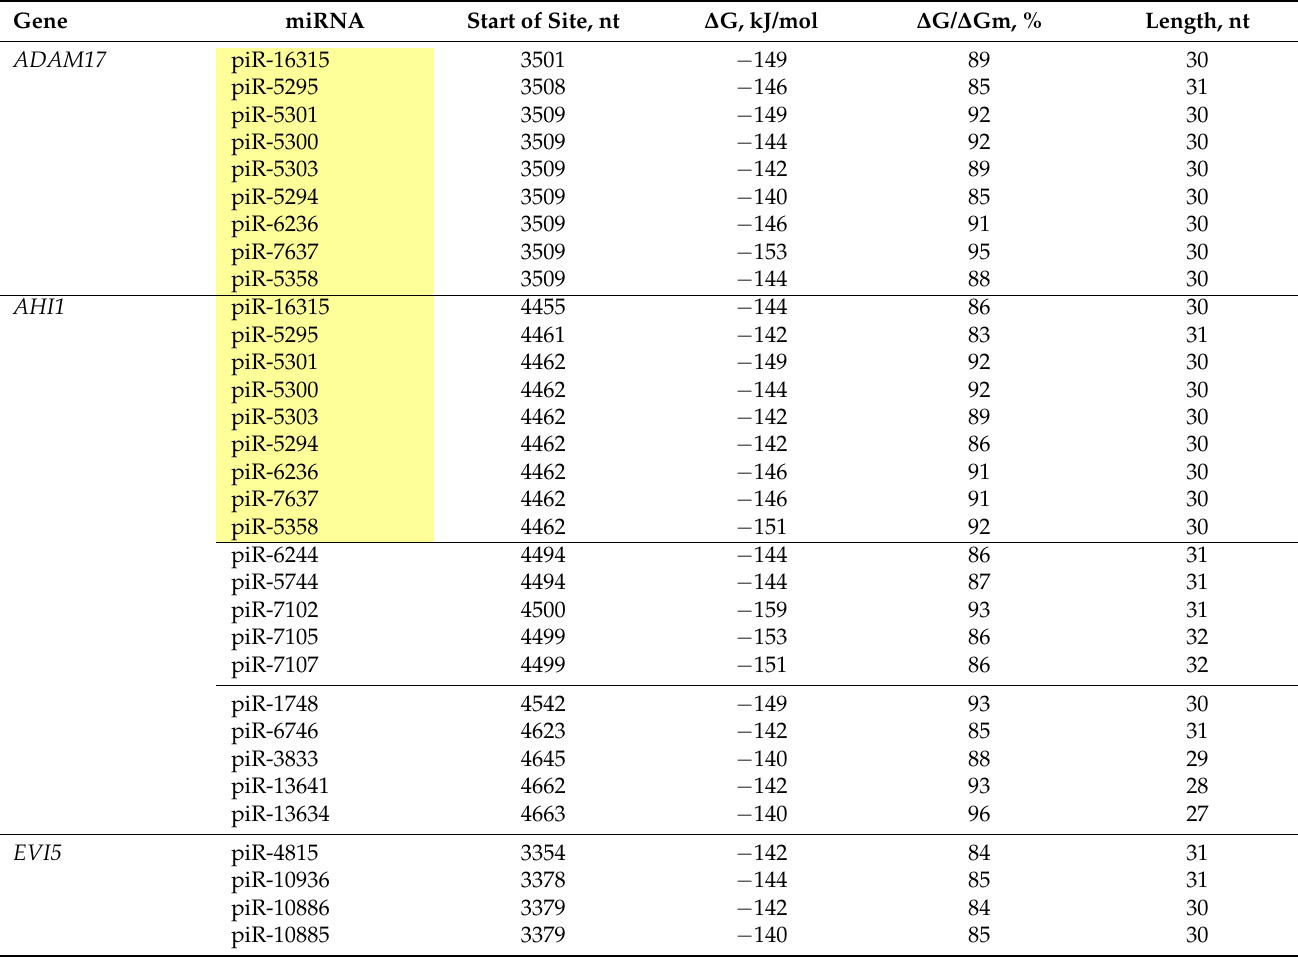
Table 5. Characteristics of interaction between piRNA and 3’UTR mRNA of MS